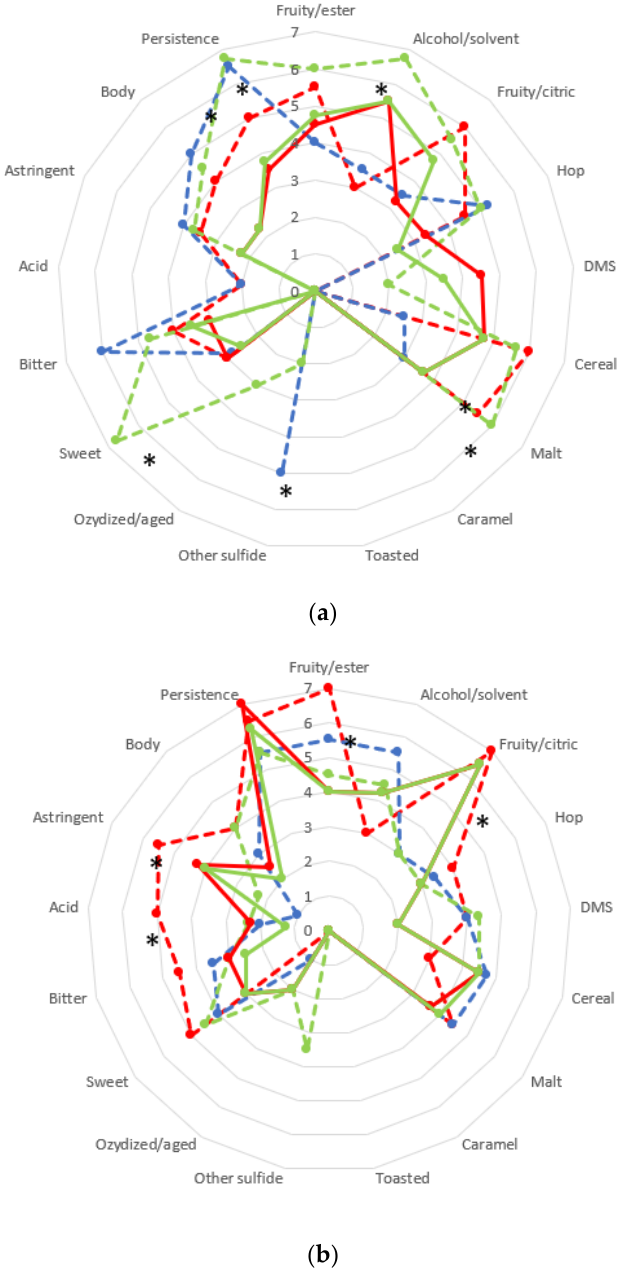
Figure 4. Sensory analysis of the beer produced by pure and mixed fermentation on pils wort ( a ) and pils wort added lentil ( b ). Pure culture of S. cerevisiae ( ), L. thermotolerans ( ) and K. unispora ( ), and mixed fermentation of S. cerevisiae / L. thermotolerans ( ) and S. cerevisiae / K. unispora ( ). * significantly different (Fisher ANOVA; p -value 0.05). DMS, Dimethyl sulphide. Score 0: absence of the descriptor analyzed.